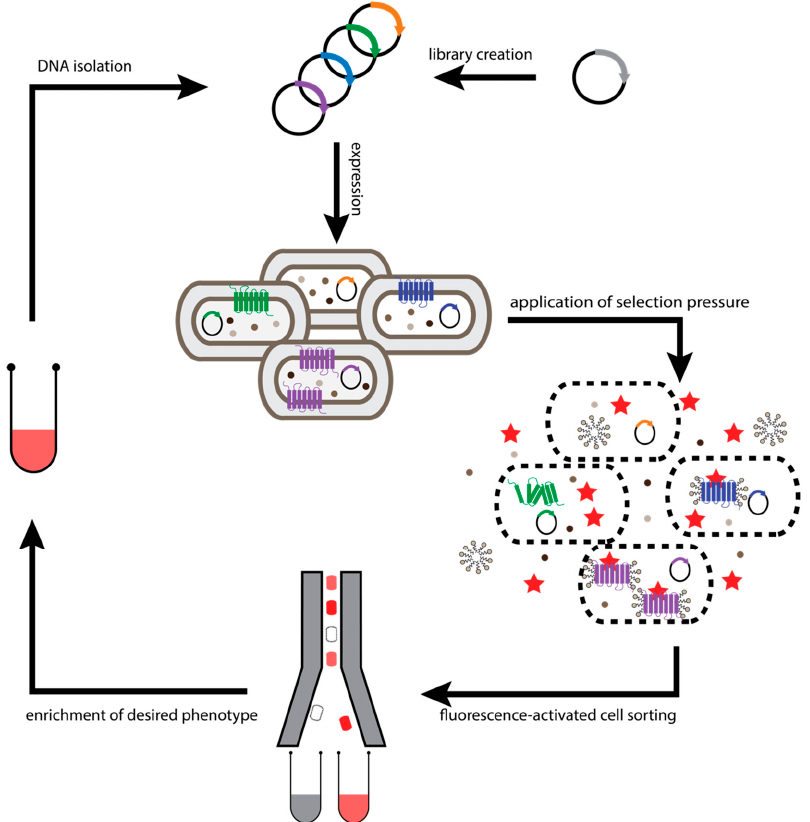
Figure 3. Workflow of Cellular High-Throughout Encapsulation, Solubilization and Screening (CHESS). Evolution of GPCRs is initiated by diversification of the receptor gene. The resulting DNA library is used for transformation of E. coli cells, so that each cell takes up at most one plasmid molecule. Subsequently, one receptor variant is expressed in the inner membrane of a bacterial cell. To probe receptor stability in detergents, the E. coli cells are encapsulated by several polymer layers (black dashed oval) and the cell membranes are solubilized with the detergent of choice. The polymer layers retain the shape of the original cell and convert it into a nanoscopic dialysis bag, as detergent molecules and ligands can traverse the capsule, while proteins cannot. After incubation with the fluorescently labelled ligand (red star), functional receptor levels determine the amount of fluorescent ligand retained. The capsules exhibiting the highest fluorescence (i.e., capsules containing the most stable GPCRs) are enriched by FACS. Enriched capsules of course cannot be re-grown, therefore the sequences of GPCR contained in the enriched capsules are amplified by polymerase chain reaction (PCR) and cloned into a new plasmid backbone to repeat the process or analyze individual clones.